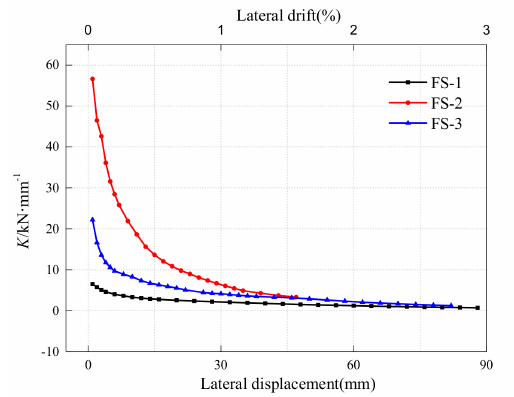
Figure 11. Stiffness curves.